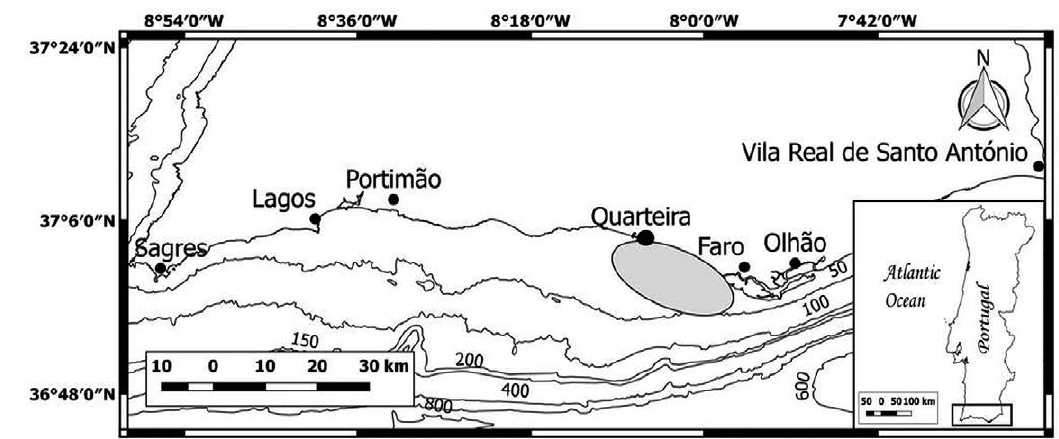
Fig. 2. – Location of the experimental fishing trials (the shaded area indicates the area off the port of Quarteira, south of Portugal) and the main ports of the Algarve